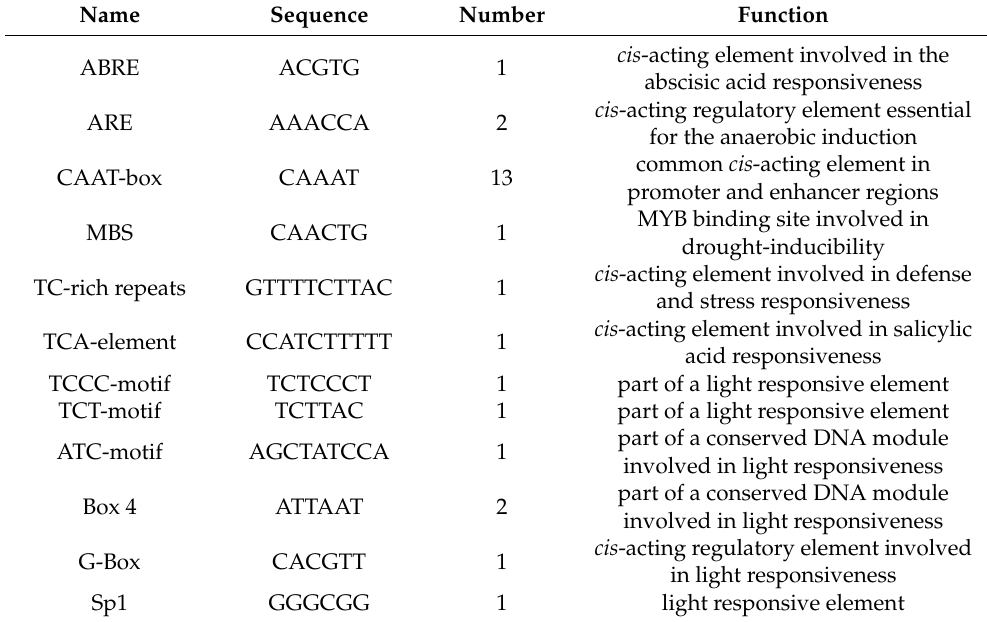
Table 1. Cis -acting element